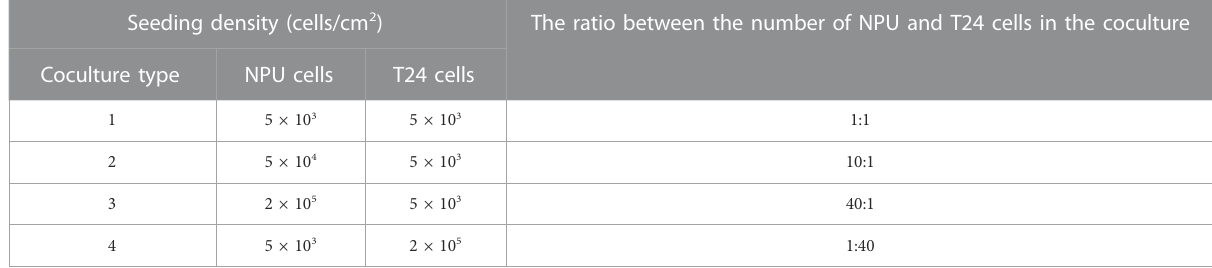
TABLE 1 Four types of cocultures of NPU and T24 cells with different combinations of seeding densities. Seeding density (cells/cm 2 ) The ratio between the number of NPU and T24 cells in the